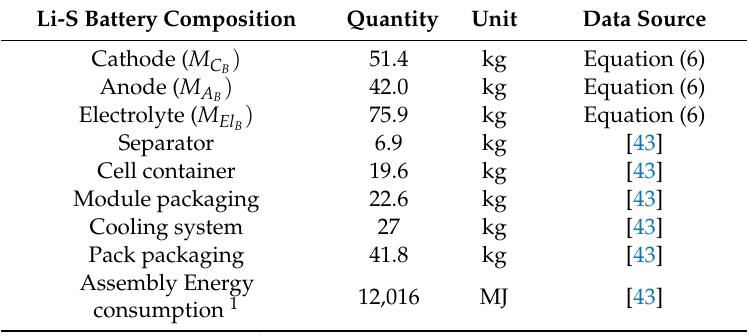
Table 3. Bill of materials for the 50 kWh Li-S